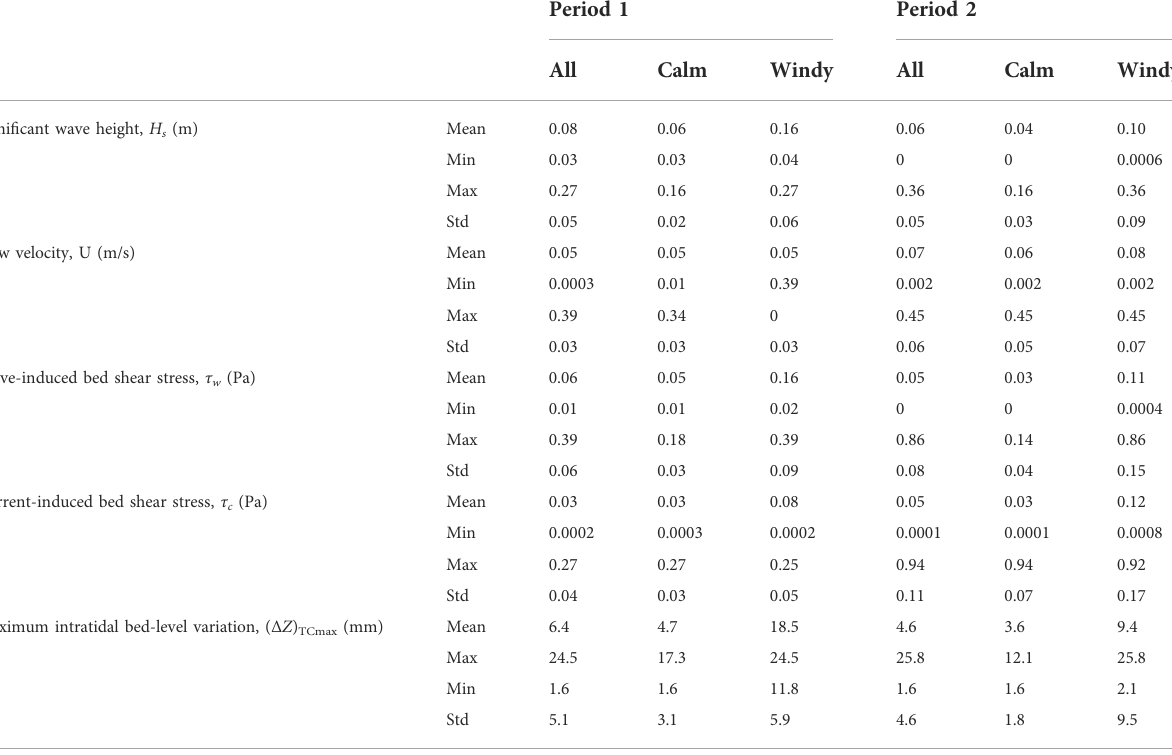
TABLE 1 Statistics of key hydrodynamic parameters.